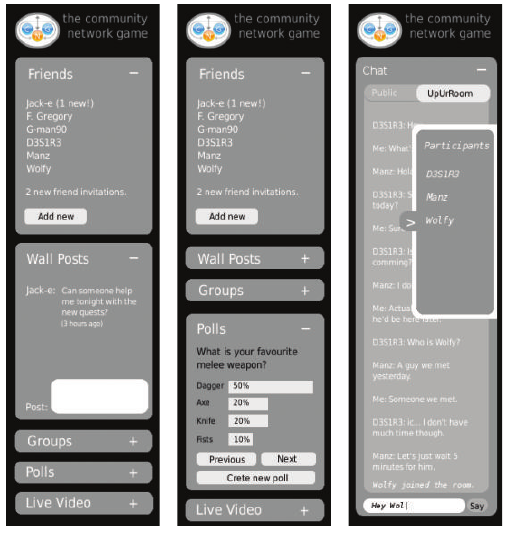
Figure 3: Examples of CNG community and collaboration tools’